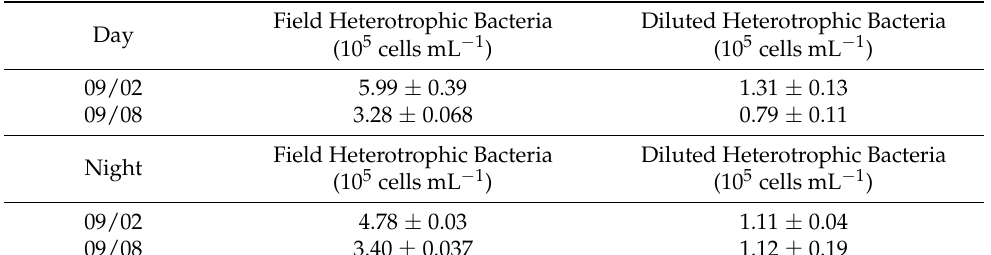
(Table 2). The percentage of bacteria lysed calculated from B lysis -L ( R lysis -L) was higher at day, but the percentage calculated from B lysis -M ( R lysis -M) was similar between day and night (Table 2). On 8 September, B lysis -L were 100 times and B lysis -M was nearly 7 times higher during the daytime than in the nighttime incubations (Table 2). The percentage of bacteria lysed calculated from both methods was higher at day (Table 2). Table 1. Non-diluted and diluted density of heterotrophic bacteria at the beginning of incubation at day and night. Values after ± are standard deviations of the three replicates of sampling.